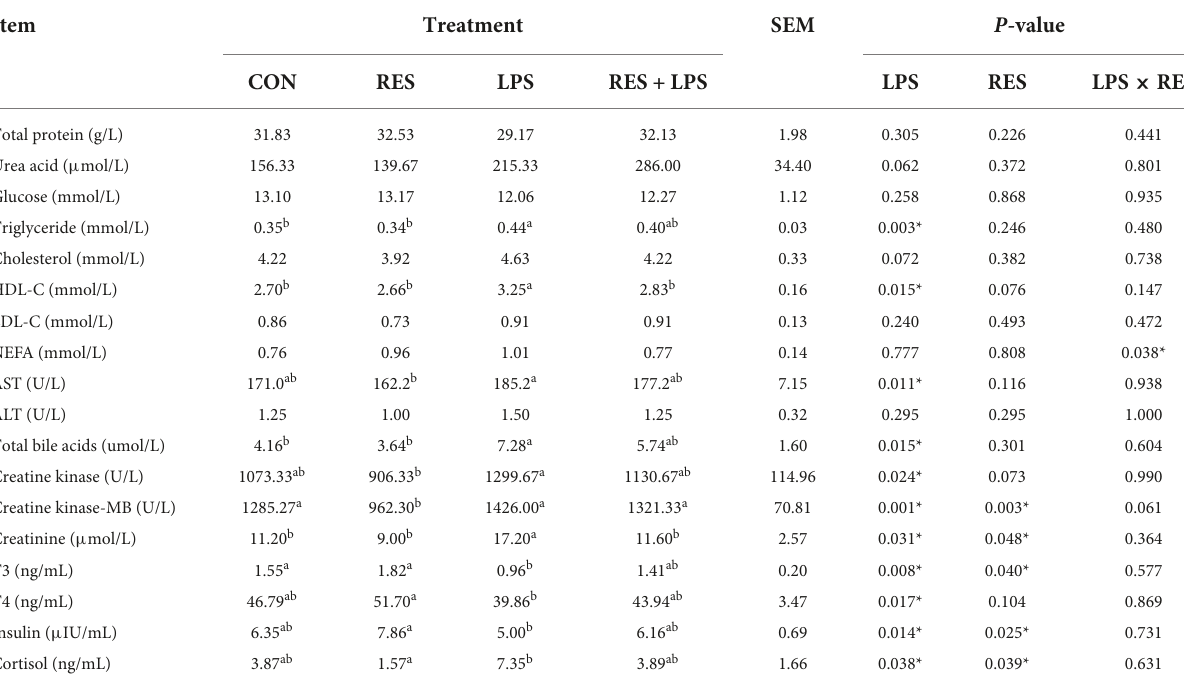
TABLE 4 Effect of dietary resveratrol supplementation on plasma biochemical parameters and hormones concentrations in yellow-feathered broilers with lipopolysaccharide 1